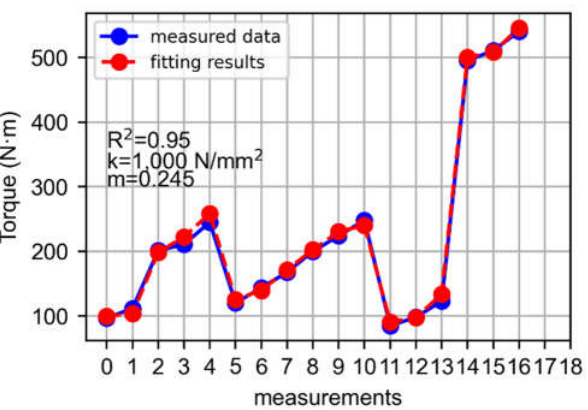
Figure 9. Measured and fitting torque data according to DoE conventional experiments. Measurement number and cutting conditions defined by Table 2.